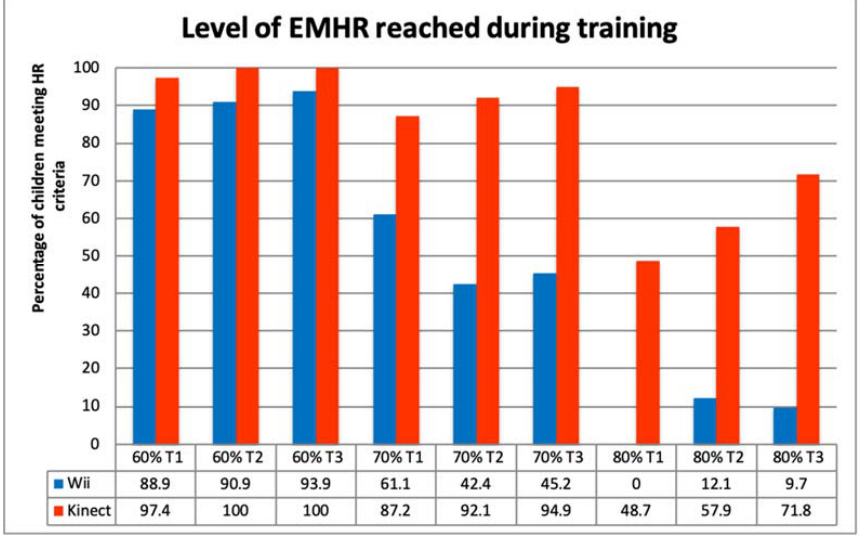
Figure 5. Percentage of children meeting the 60, 70 and 80% level of their estimated maximum heart rate.